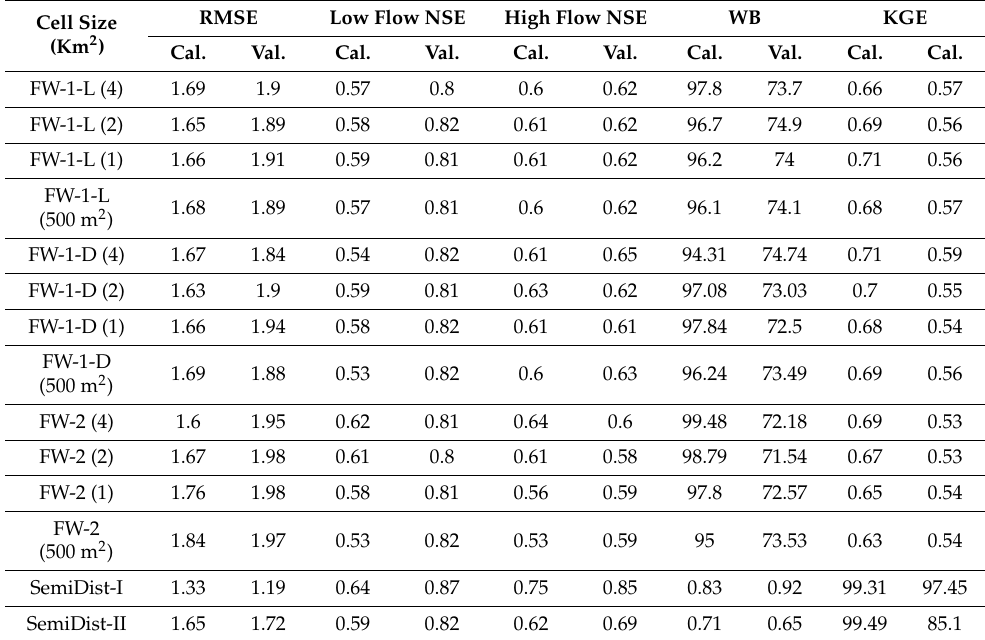
Table 4. Model performance statistics for all models during calibration and validation periods.